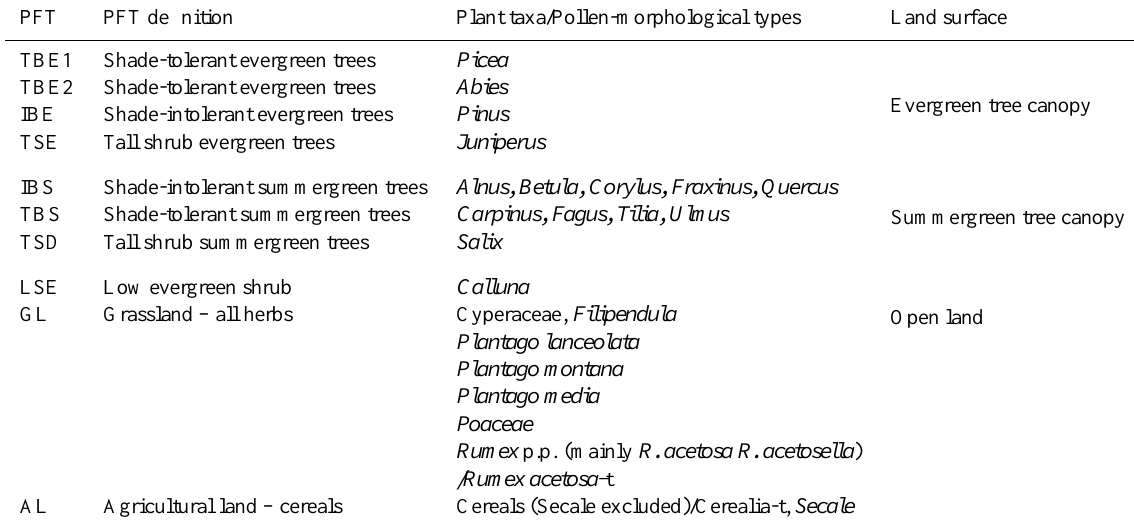
Table 1. PFTs used in the LANDCLIM project (see text for more explanations). The ten PFTs in the left column and the three land-surface types in the right column are used in the dynamic vegetation model LPJ-GUESS and regional climate model RCA3, respectively. The PFTs are a simplification of the PFTs described in Wolf et al. (2008). The corresponding 24 plant taxa for which REVEALS reconstructions are performed in the project are indicated in the middle column. These plant taxa have specific pollen-morphological types; when the latter corresponds to a botanical taxon, it has the same name; if not, it is indicated by the extension